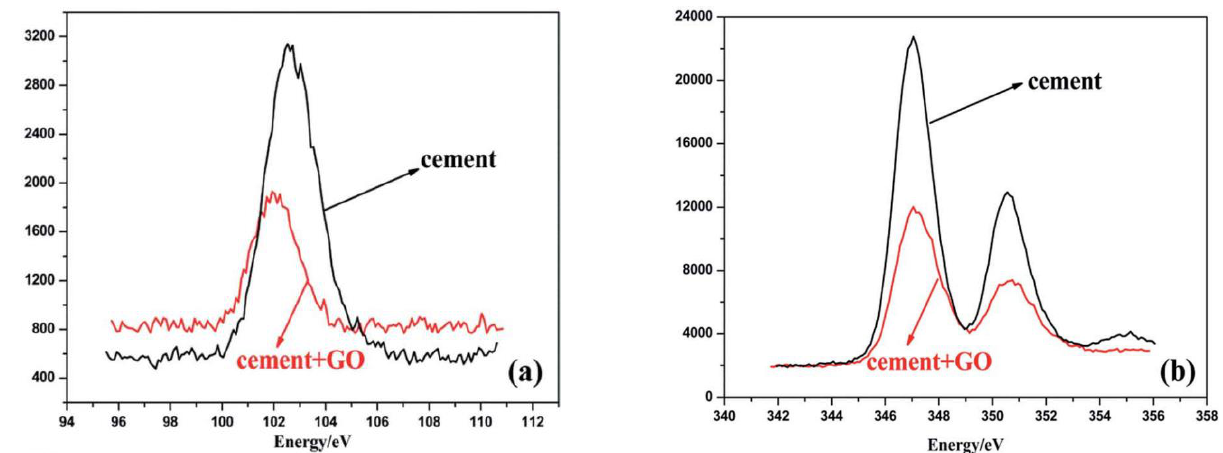
Figure 14. XPS results of cement surface with and without GO ( a ) Si 2p; ( b ) Ca 2p. Reprinted with permission from Ref. [51]. Copyright 2016 RSC Publishing.